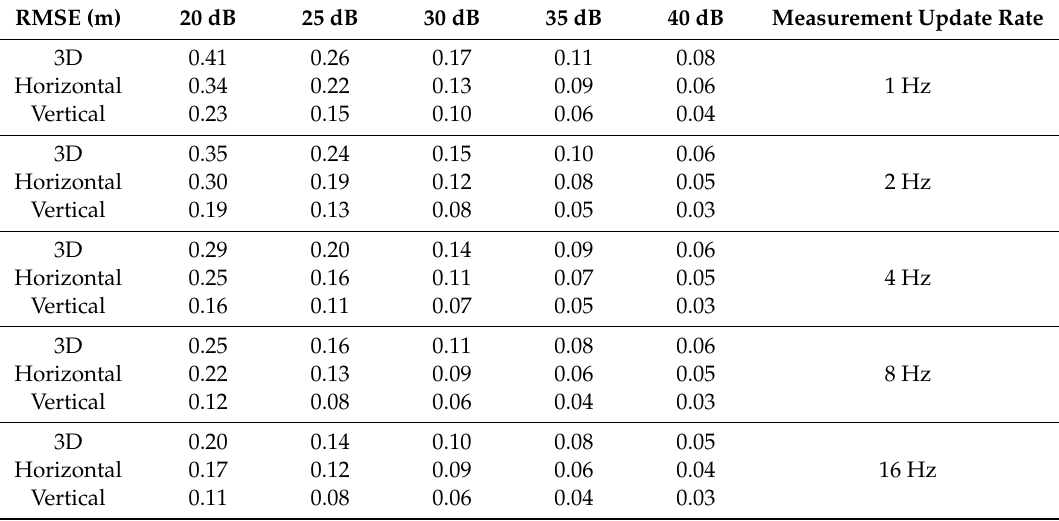
Table 4. Best accuracies obtained at all investigated SNR levels and measurement update rates in the horizontal circular path